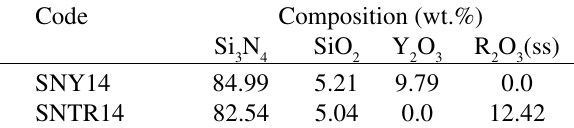
Table 2. Compositions of the prepared powder mixtures